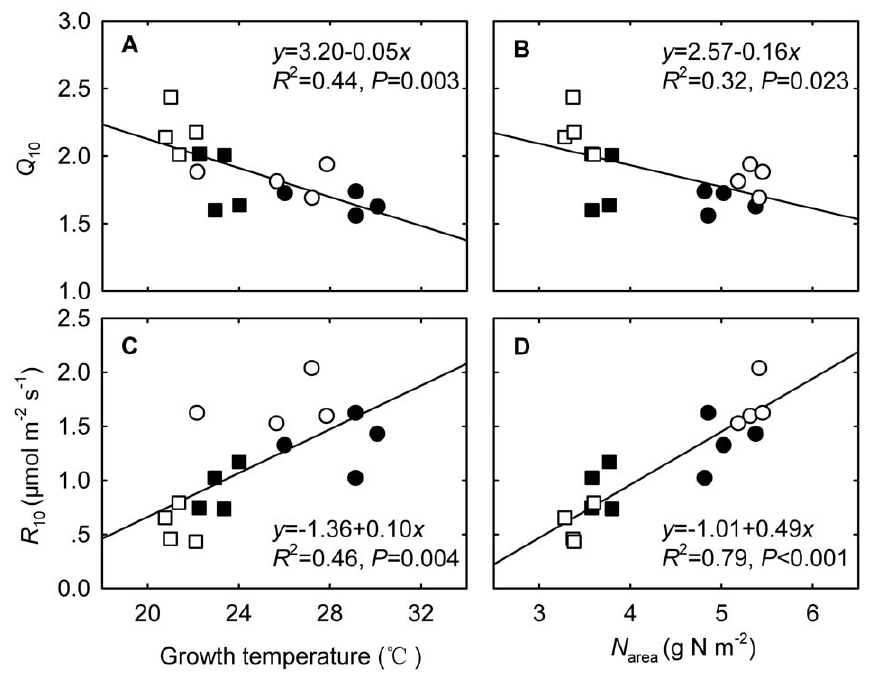
Figure 7. Responses of Q 10 (the temperature sensitivity) (top panel) and R 10 (the estimated basal respiration rate at the reference temperature of 10 6 C) (lower panel) in the control (open) and warming (filled) plots in 2010 (circles) and 2011 (squares) to T growth (left panel) and foliar nitrogen concentrations (right panel), respectively. Values are means (n=4, 6 SE).